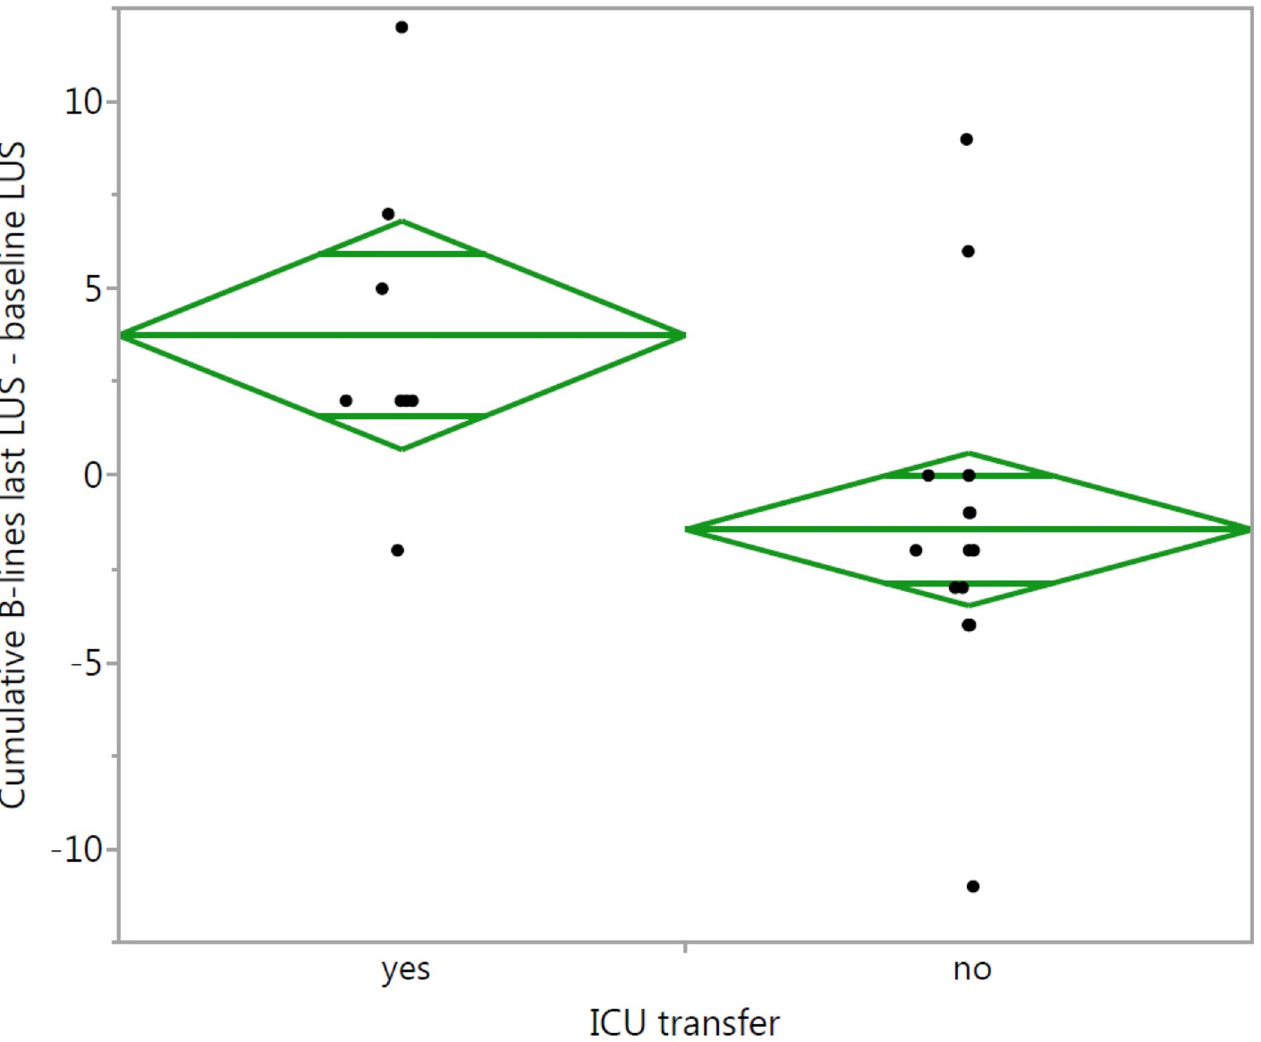
Fig 5. Oneway analysis of cumulative B-lines last LUS—baseline LUS by ICU transfer (two group diagram).